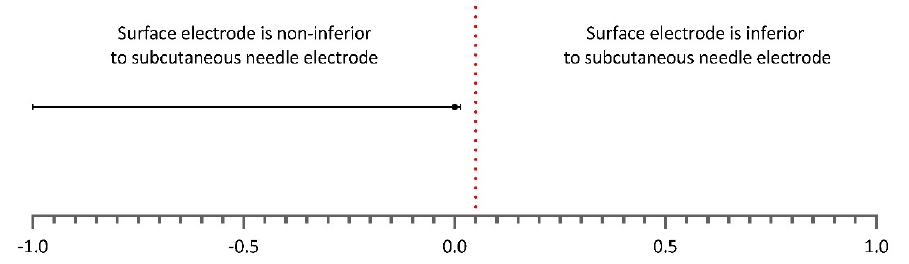
Figure 2. Difference in proportions of warnings detected by the use of subcutaneous needle and surface electrodes. The one-sided 95% CI is reported. The vertical dotted red line indicates the non-inferiority margin of 5.0%. As can be observed, the estimate and one-sided 95% CI remain on the left side of the dotted line, which implies non-inferiority of the use of surface recording electrode in detecting mTc-MEP warnings over the TA muscles.